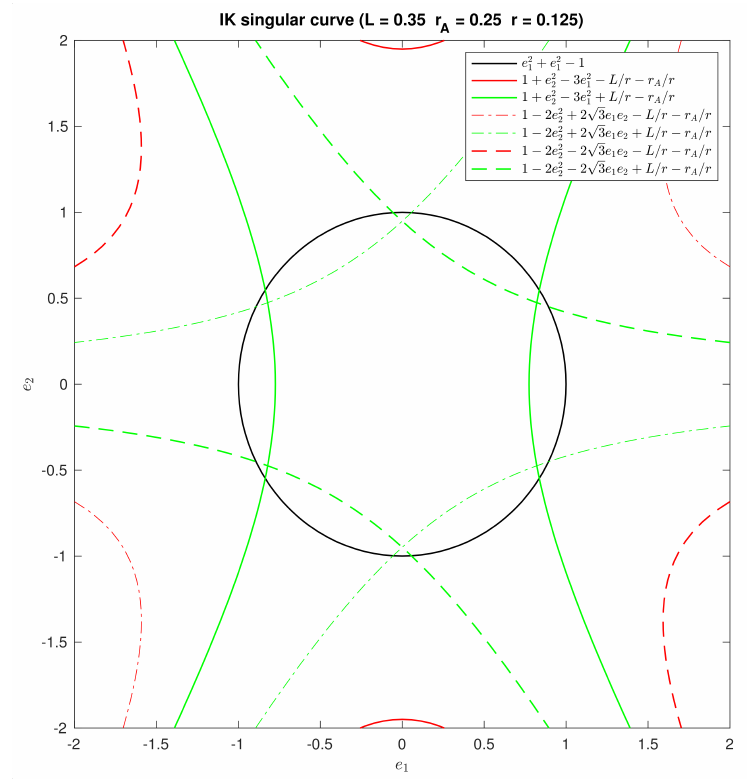
Figure 5. IK singularity locus for 3 PRS